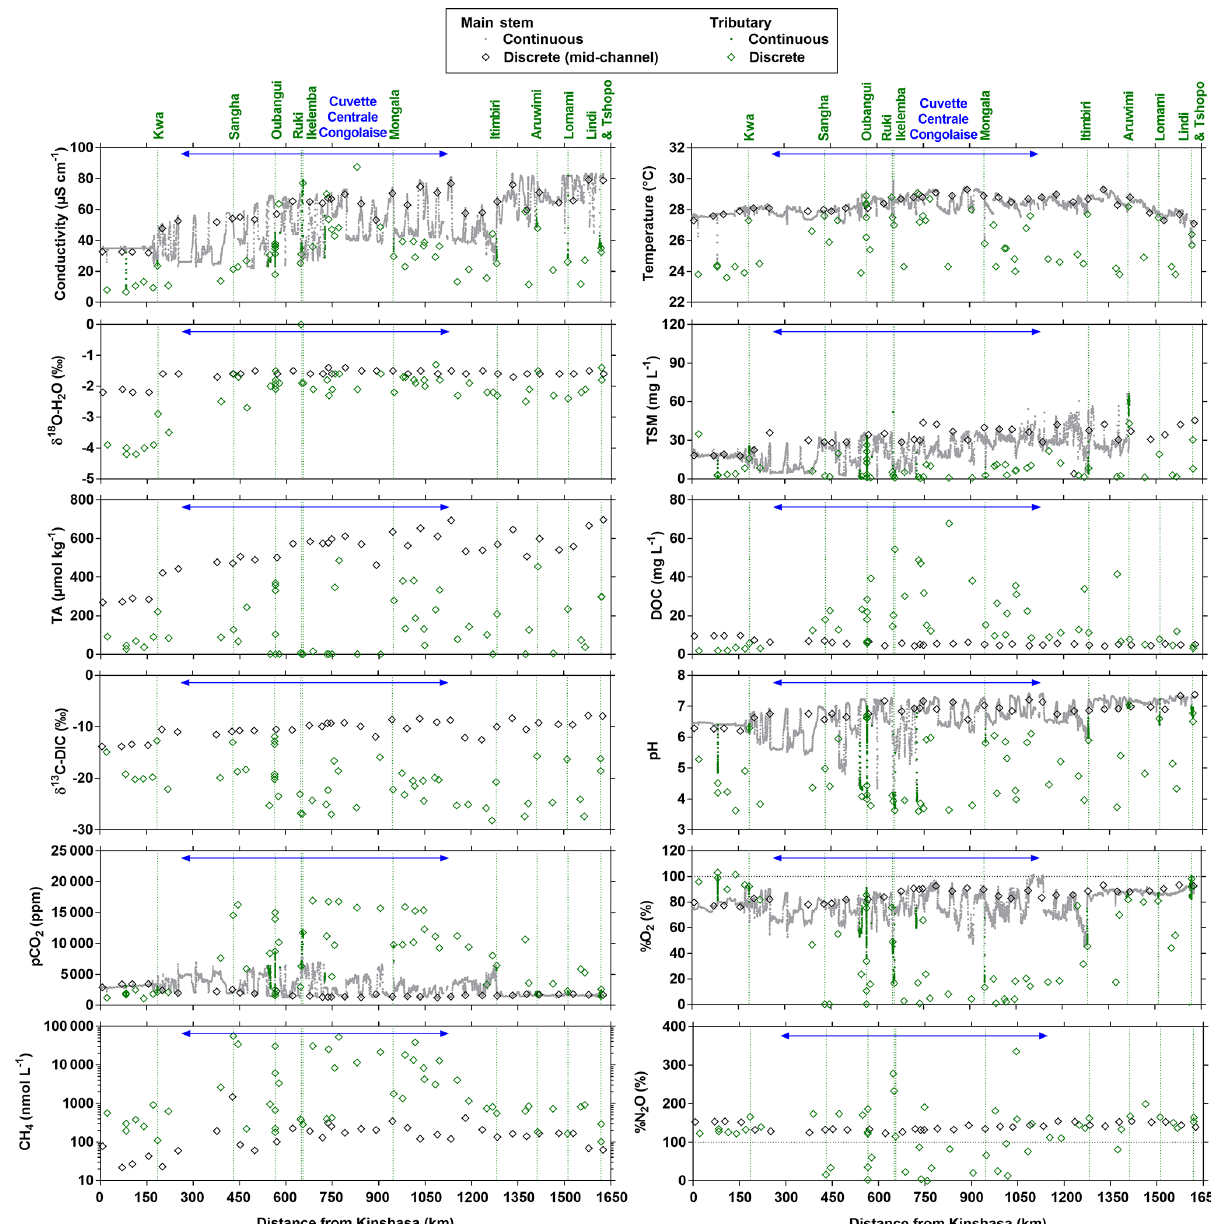
Figure 4. Variation in surface waters of the specific conductivity (µScm − 1 ), water temperature ( ◦ C), oxygen stable isotope composition of H 2 O ( δ 18 O-H 2 O in ‰), total suspended matter (TSM in mgL − 1 ), total alkalinity (TA in µmolkg − 1 ), dissolved organic carbon (DOC in mgL − 1 ), carbon stable isotope composition of dissolved inorganic carbon ( δ 13 C-DIC in ‰), pH, partial pressure of CO 2 ( p CO 2 in ppm), dissolved O 2 saturation level (%O 2 in %), dissolved CH 4 concentration (nmolL − 1 ) and dissolved N 2 O saturation level (%N 2 O in %) as a function of the distance upstream of Kinshasa along a transect along the Congo River from Kisangani (10–30 June 2014, n = 12968). Grey and black symbols indicate samples from the main stem and green samples from